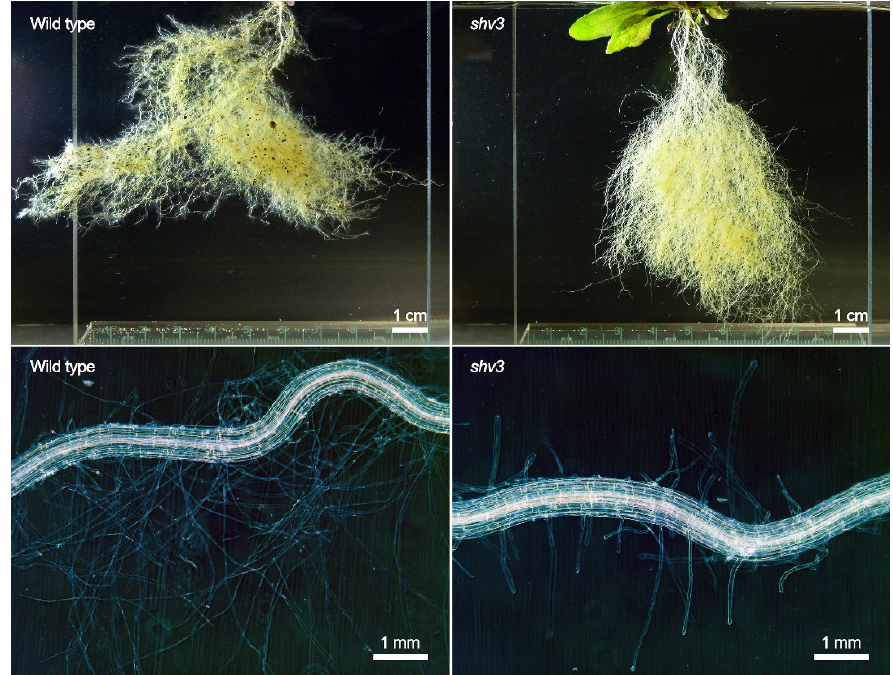
Figure 4. Root system ( top ) and root hair zone ( bottom ) of representative uninoculated A . thaliana wild type ( left ) and shv3 mutant plants ( right ) grown in sterile sand.